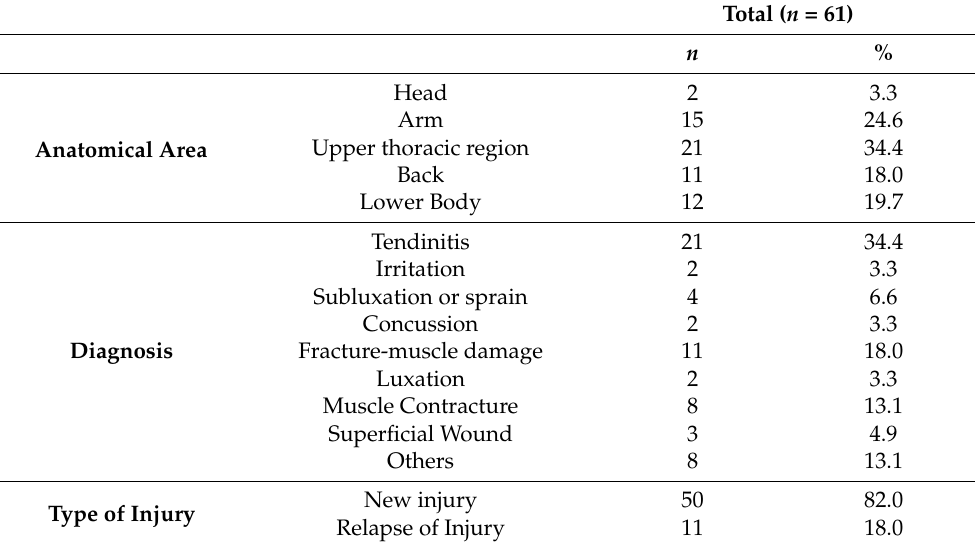
Table 2. Characteristics of recorded